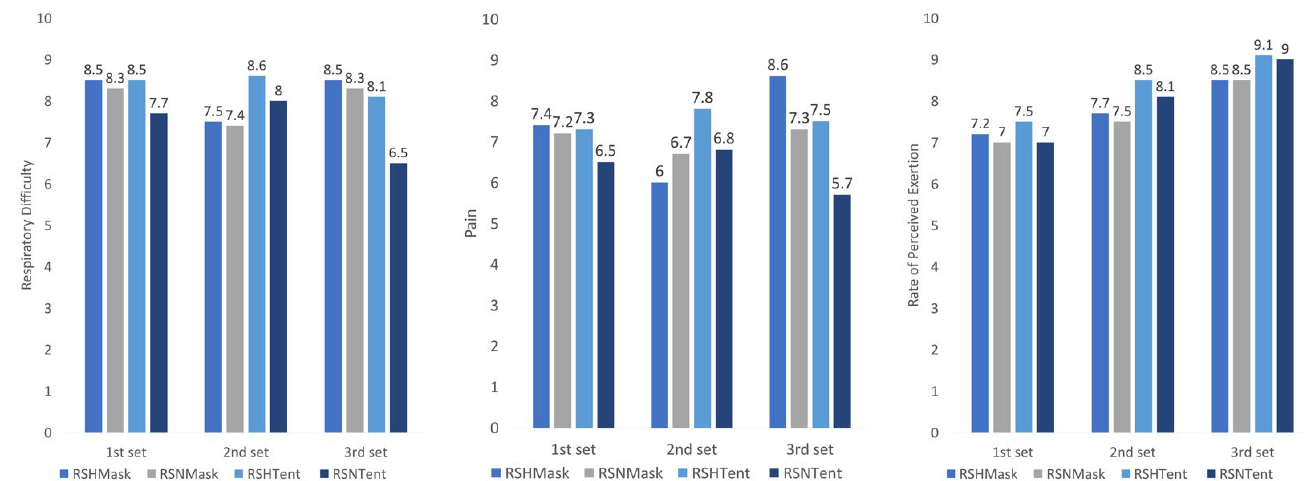
Figure 4. Changes in pain, exertion, and respiratory difficulty perception during a repeated-sprint workout in hypoxia and normoxia. RSH Tent = repeated-sprint in normobaric hypoxia using a tent, RSH Mask = repeated-sprint in normobaric hypoxia using a mask, RSN Tent = repeated-sprint in normoxia using a tent, RSN Mask = repeated-sprint in normoxia using a mask.